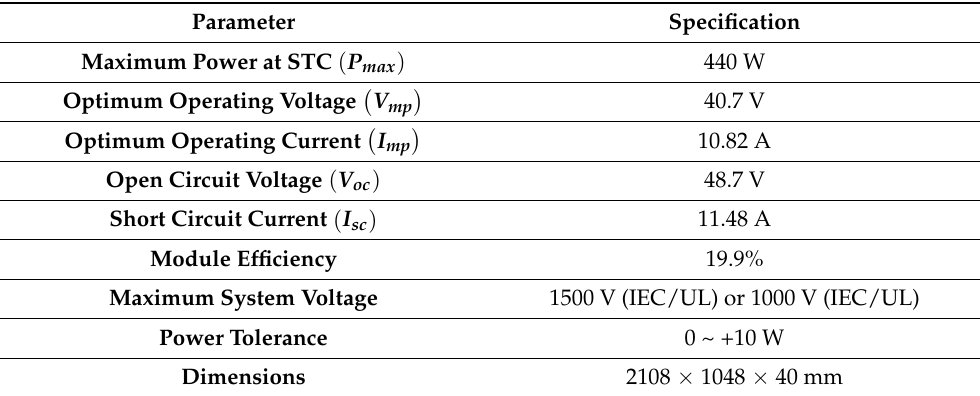
Table 2. CS3W440MS poly-crystalline module specification under STC.